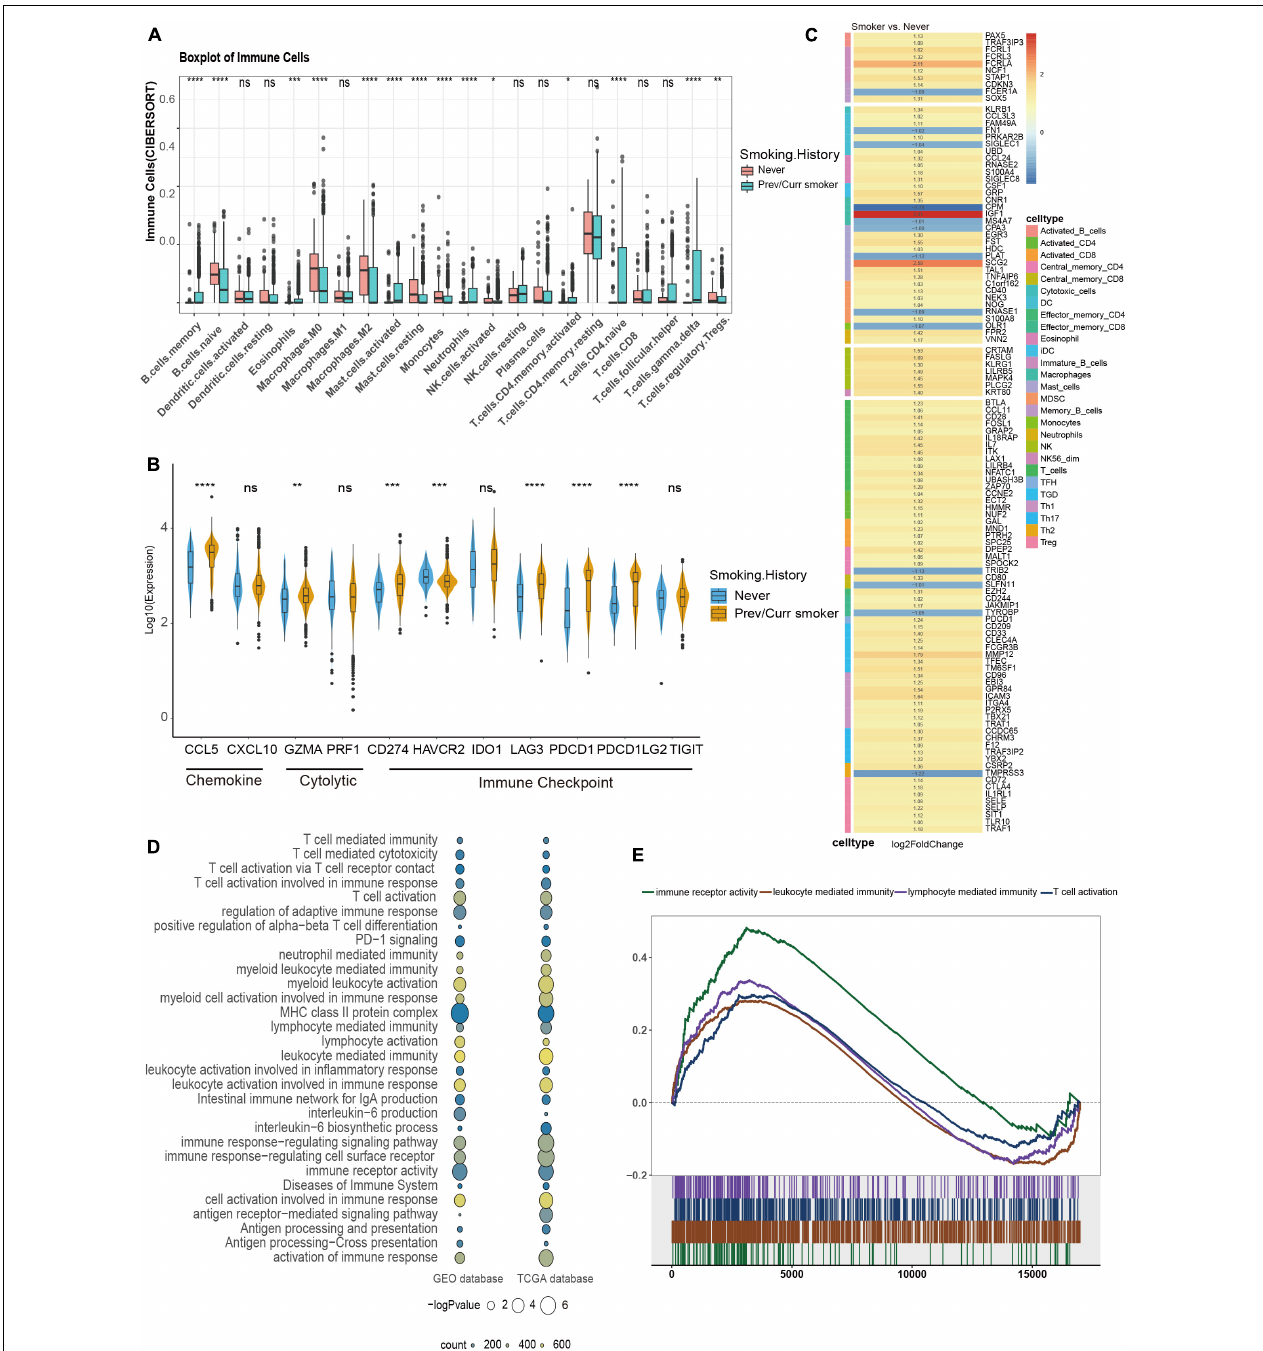
FIGURE 4 | Comparison of immune characteristics between different smoking status in NSCLC. (A) CIBERSORT analyses quantifying the proportion of 22 immune cells in the different smoking status of the NSCLC cohort from TCGA. (B) Frequencies of stimulatory immunomodulators in the different smoking status of the NSCLC cohort from TCGA. (C) Heatmap showing average changes in the expression levels of immune-related gene between the previous or current smokers and non-smokers in the TCGA cohort. The genes corresponding to the same lymphocyte or function are identified by the same color on the left side of the squares, and each square with an exact number represents the logFC of a gene, filled with different back colors, i.e., from red to gray. The logFC values marked in black font indicate that the absolute value of logFC is ≥ 1 with statistical significance ( p < 0.05). (D) The bubble chart shows that immune-related pathways are significantly different under different smoking states of TCGA and GEO dataset, the color of the circles indicates counts, as shown in the legend, and the size is proportional to the statistical significance. (E) GSEA of the hallmark gene sets downloaded from MSigDB. All transcripts were ranked by the log2 (fold change) between previous or current smokers and non-smokers in the TCGA cohort. Each run was performed with 1,000 permutations; immune-related pathways are highly enriched in the smoking group of TCGA cohort. * p < 0.05; ** p < 0.01; *** p < 0.001; **** p < 0.0001; ns, not significant.